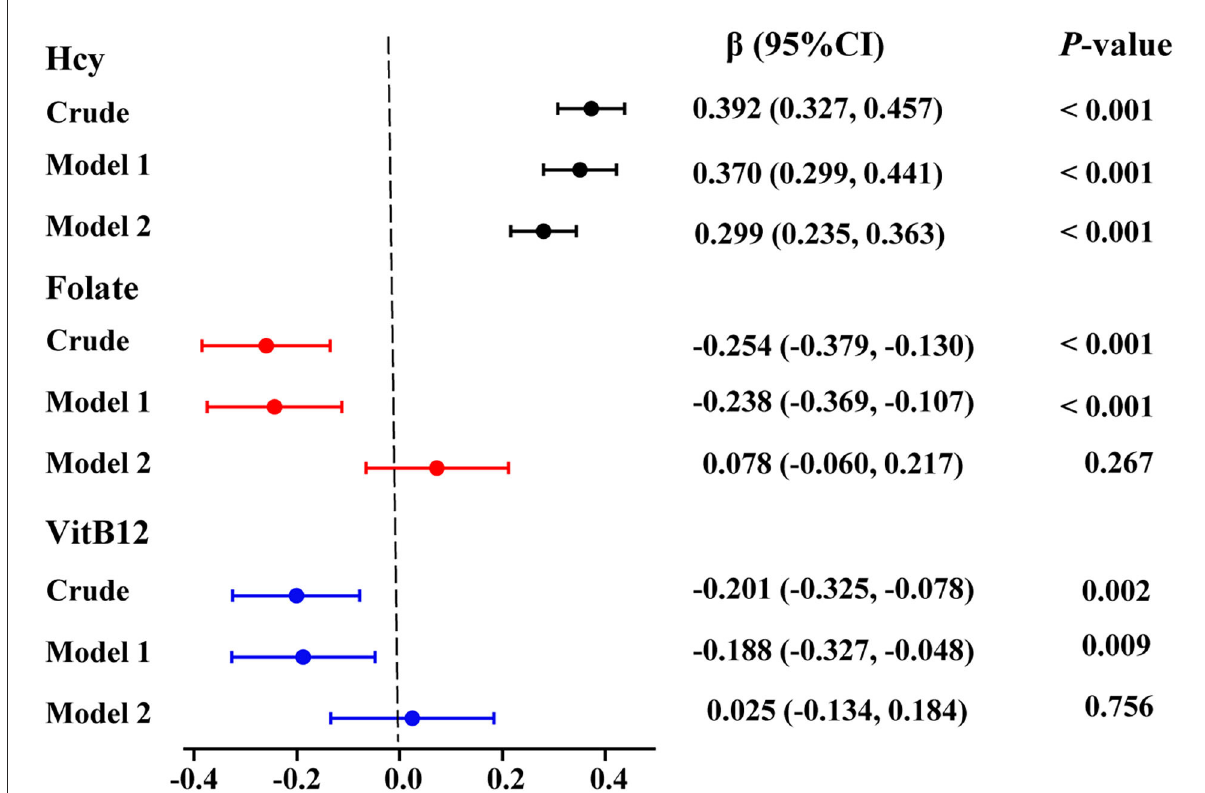
FIGURE2 Multivariate linear logistic regression analysis for the associations between serum Hcy, folate, and VitB12 levels and ASD. Colored points represent the adjusted regression coefficient ( β ), and horizontal lines represent the 95% CI. “Crude” means no adjustment. Model 1 was adjusted for age, sex, BMI, picky eating, and use of vitamins. Model 2 was adjusted for model 1 and the other two metabolites. Hcy, homocysteine; VitB12, vitamin